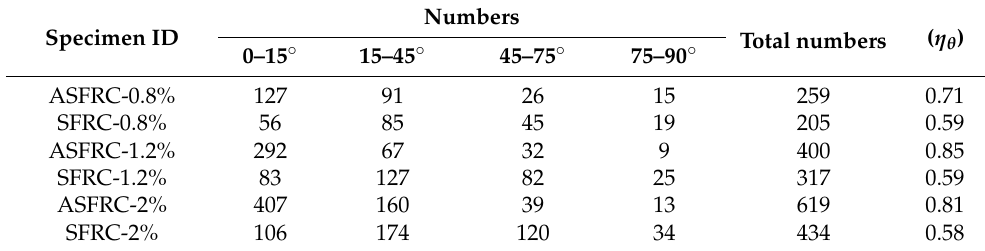
Table 4. Number of steel fibers in fractured cement-based composite